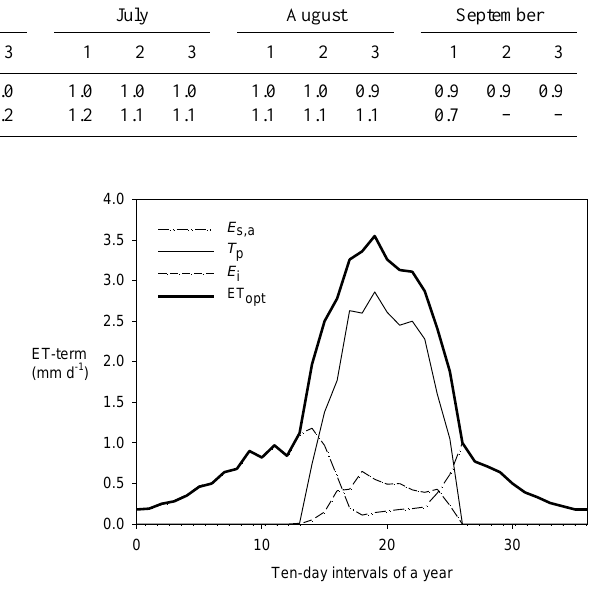
Fig. B1 Fig. B1. Total evapotranspiration of unstressed potato (ET culated directly from the “all-in-one” K c,tot factor multiplied by ET 0 and calculated with K cb (LAI) multiplied by ET 0 plus the ac- tual soil evaporation E s,a , per ten-day interval, averaged over 30yr (1971–2000).